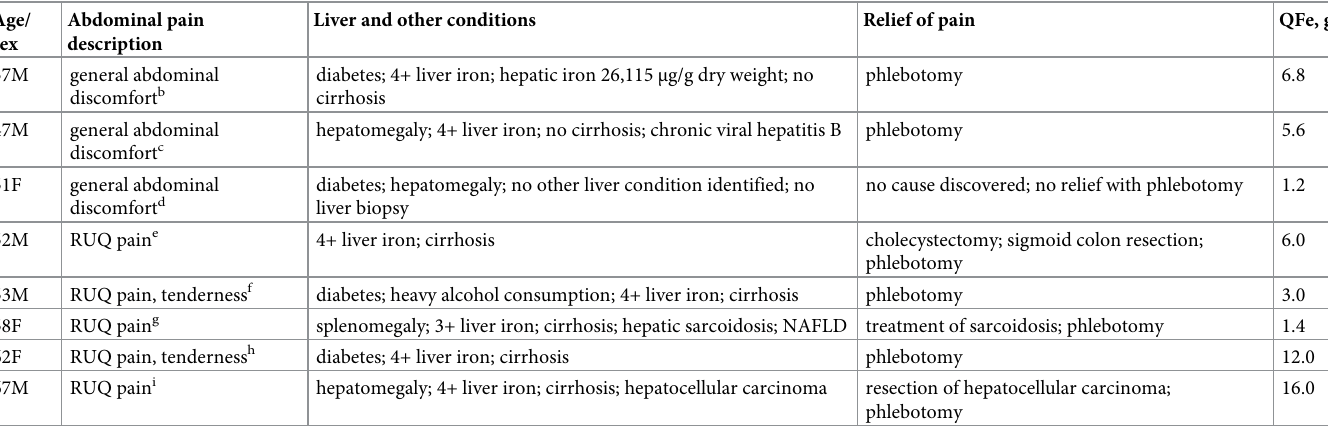
Table 4. Hemochromatosis probands with HFE p.C282Y homozygosity and abdominal pain a .